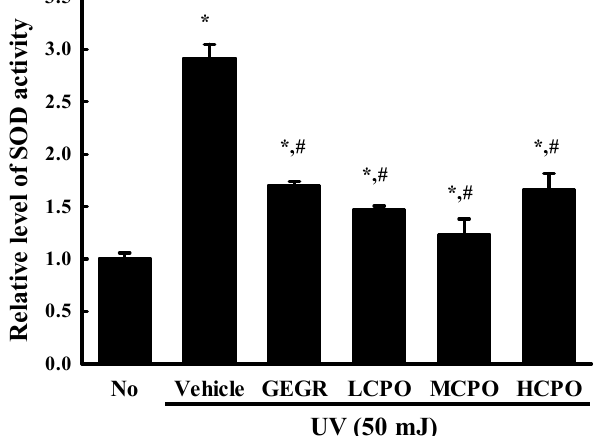
Figure 4. SOD activities in UV + CPO treated NHDF cells. SOD activities were measured in cell lysates as described in Materials and Methods. One SOD unit was defined as the amount of enzyme in 20 µ L of sample solution that inhibited the reduction of WST-1 with superoxide anion by 50%. Two to three wells per group were used and SOD activity was measured in duplicate. Data are reported as the means ± SD. * p < 0.05 compared to the No group. # p < 0.05 compared to the UV +